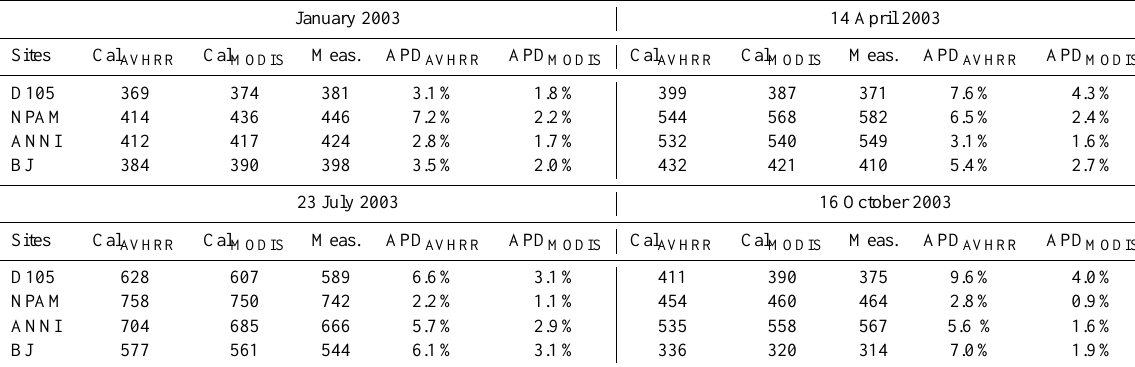
Table 2. Comparison of the derived net radiation flux from AVHRR (Cal AVHRR ) and MODIS (Cal MODIS ) vs. the values measured (Meas.) at the Tibetan Plateau with absolute percent difference (APD) in 2003.